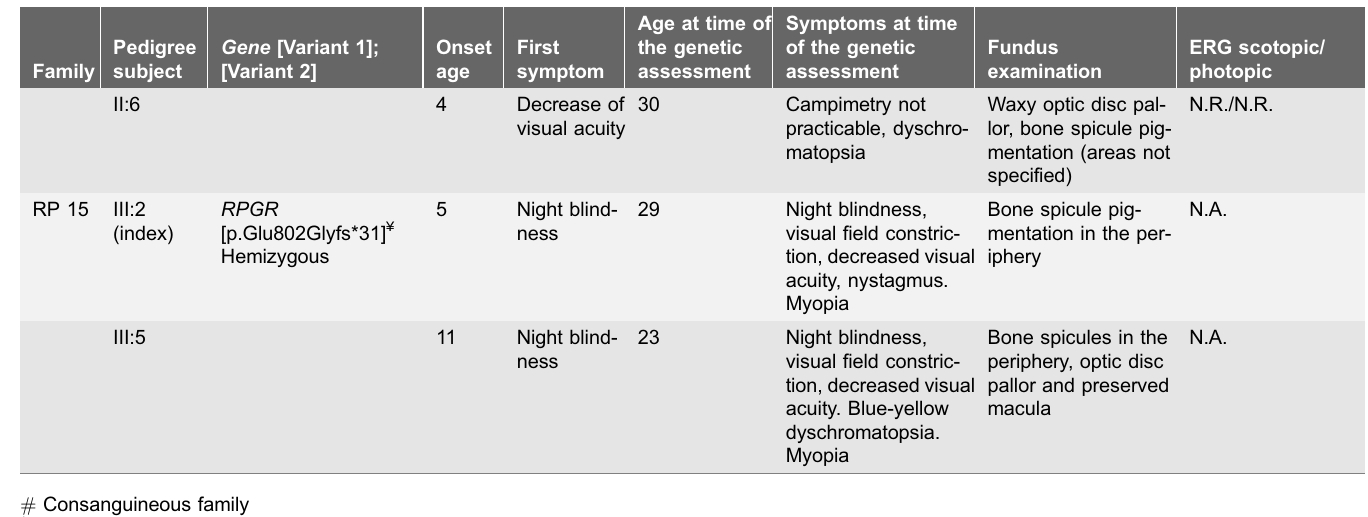
2406delAG; p.Glu802Glyfs*31 in exon ORF15 of RPGR (S1 Fig.), (Table 1). No other disease-causing variants or genetic modifiers were detected by WES in none of the analyzed families.